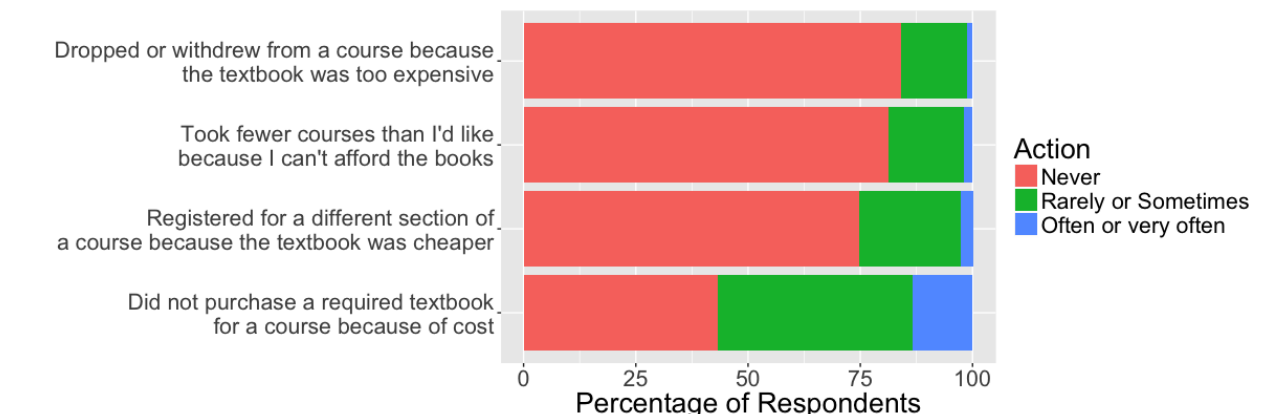
Figure 1 . How often respondents have taken certain actions as a result of textbook costs. N=150.